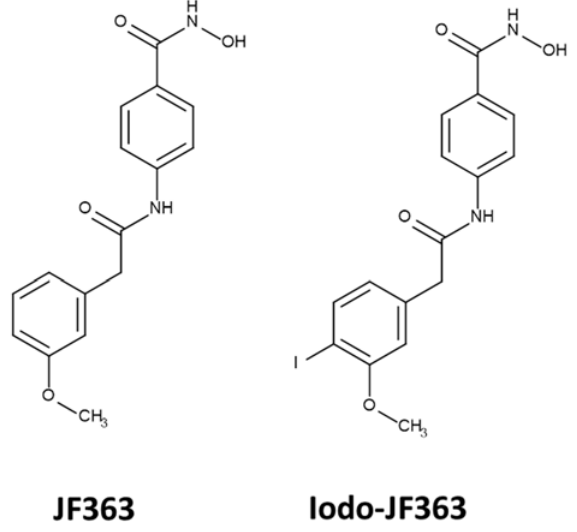
Figure 8. Chemical structure of the JF363 and iodo-JF363 used in the